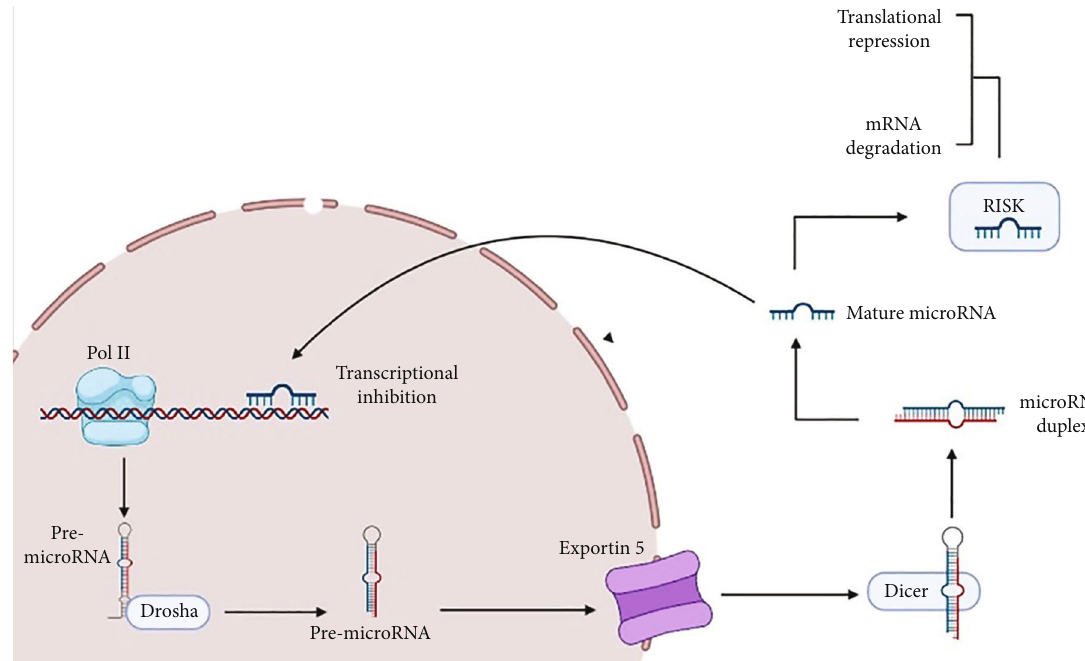
Figure 1: The process of microRNA transcription, maturation, and function in the